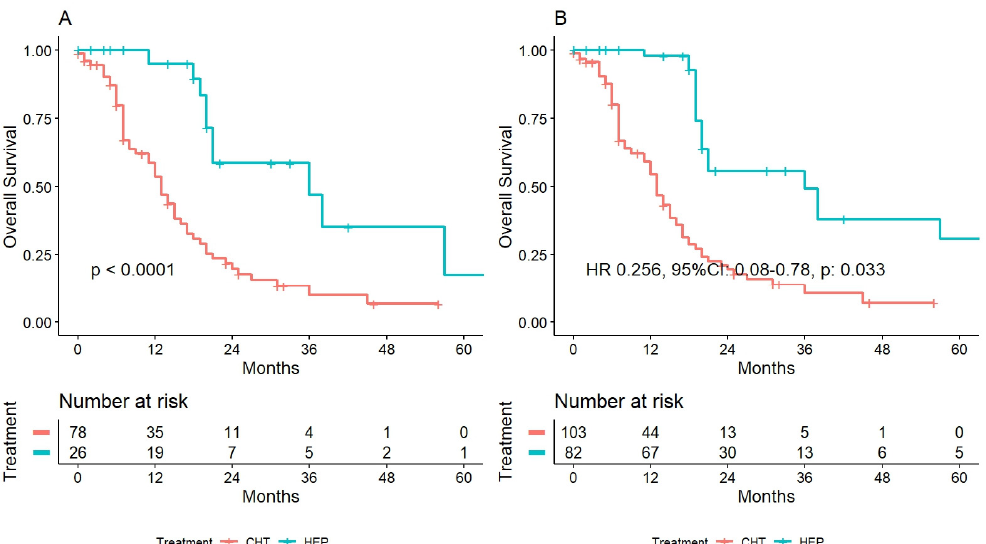
Figure 1. Overall survival among patients treated with hepatectomy following perioperative chemotherapy (HEP) and prosecution of chemotherapy alone in case of disease progression: ( A ) before the inverse probability weighting, and ( B ) after it.